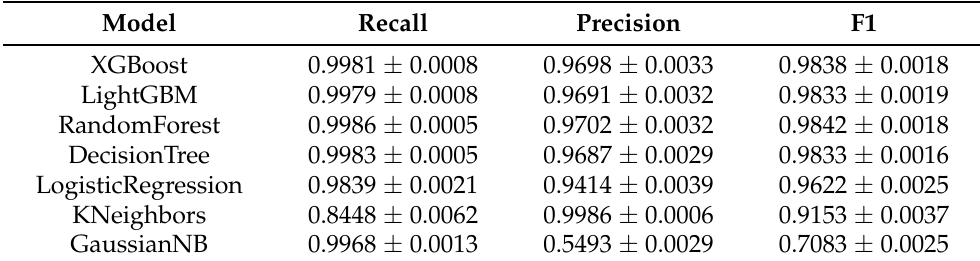
Table 2. Performance comparison using AST-JS node